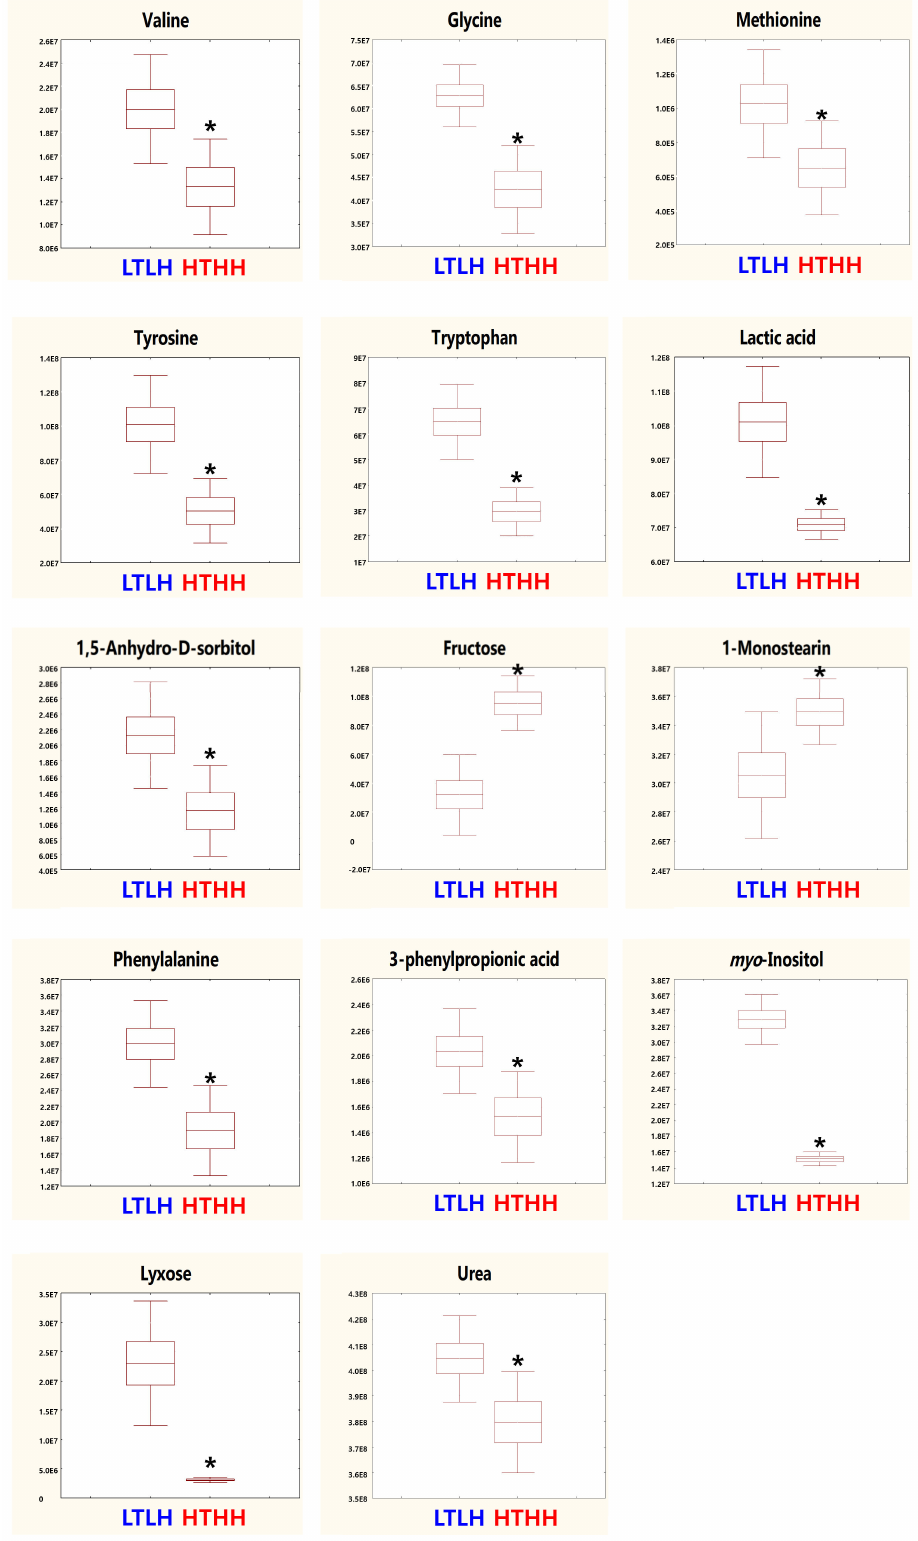
Figure 3. Metabolomics in dairy cows ( n = 4) exposed to two distinct environmental conditions. Serum was assessed. LTLH vs. HTHH; VIP > 1.0, p < 0.05. Values (mean ± SEM) with asterisk (*) differ significantly, compared to the LTLH group ( p <